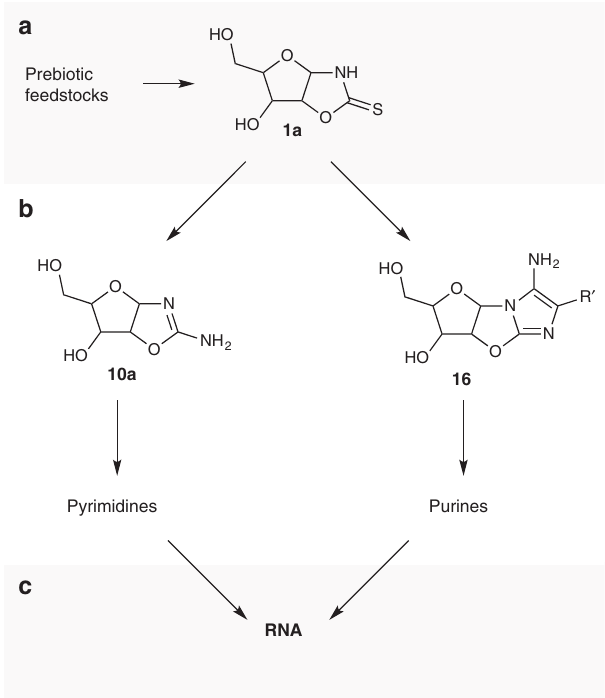
Figure 1 | Proposed prebiotic ribonucleotide synthesis by divergent nucleobase assembly on a universal furanosyl-oxazoline scaffold. ( a ) Unitary phase: the reaction of prebiotically available